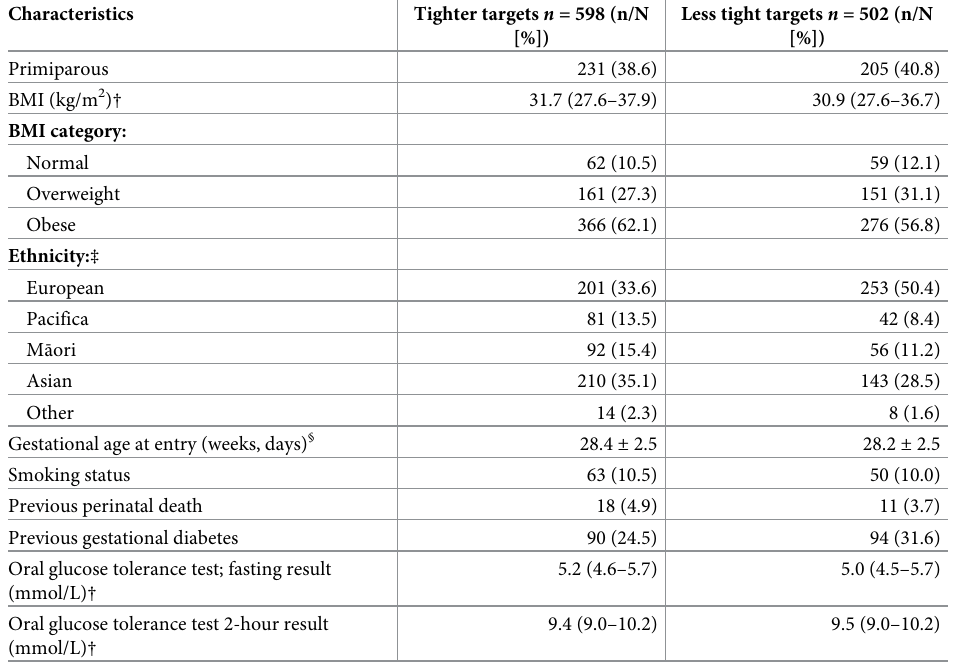
Table 1. Baseline maternal characteristics at trial